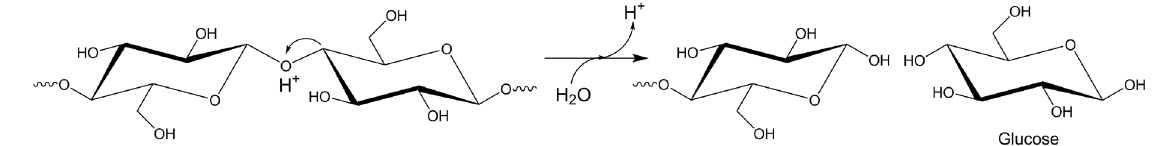
Figure 7. The mechanism of cellulose depolymerization in the presence of water and Bronsted acids [49].